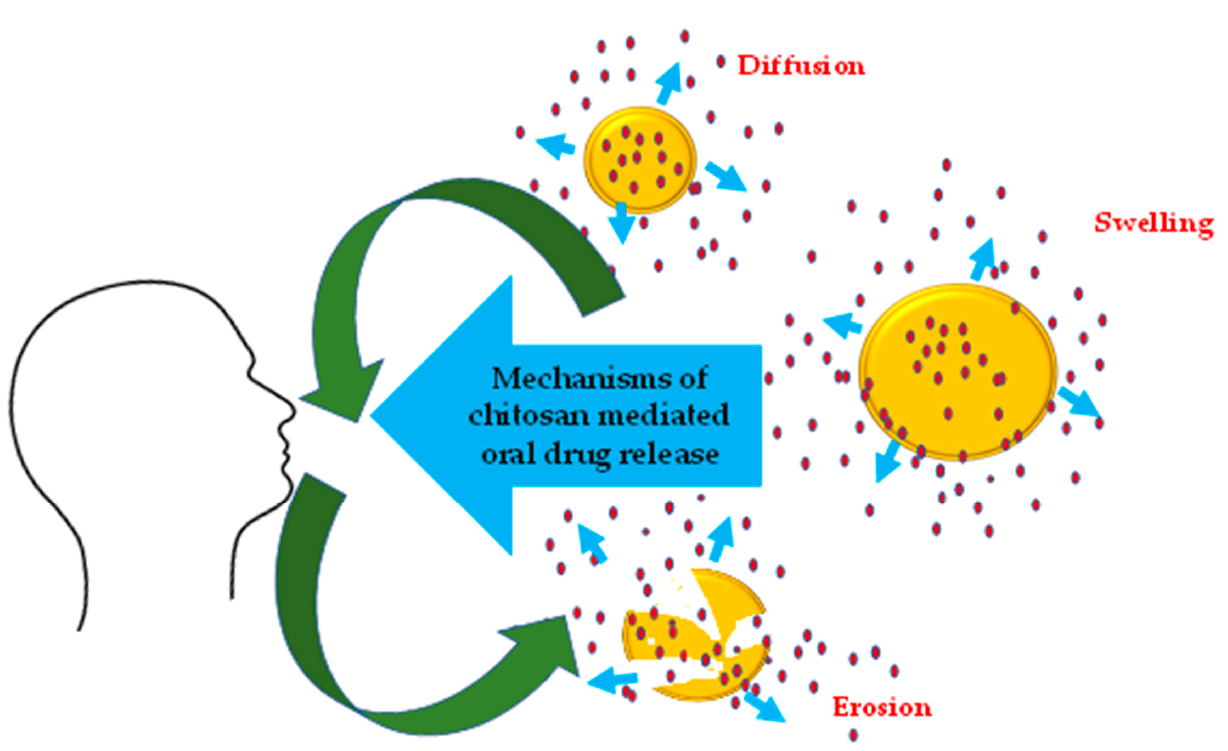
Figure 2. Mechanisms of drug release in chitosan and its derivatives.